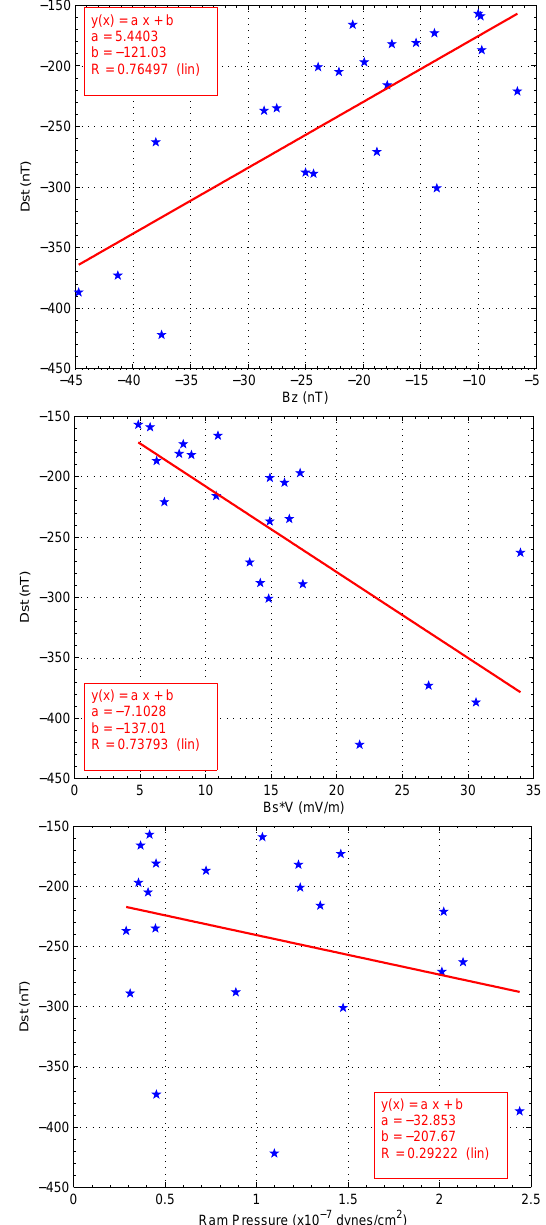
Fig. 4. Graphic representation of Dst versus various ICME param- eters: Bz vs. Dst (top panel, recorded two hours before minimum Dst), Bs · V vs. Dst (middle panel, recorded two hours before min- imum Dst) and ram pressure vs. Dst (bottom panel, recorded three hours before minimum Dst). The values of Bs · V are multiplied by 10 − 3